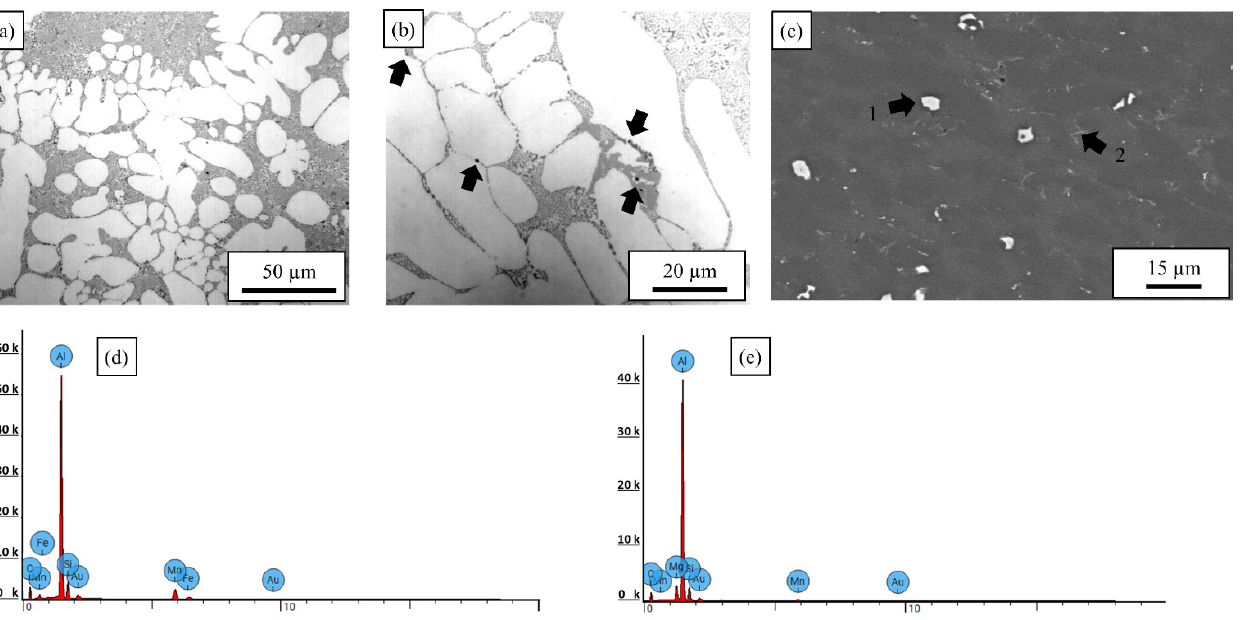
Figure 3. AlSi10MnMg base microstructure in as-cast state: ( a ) general microstructure view; ( b ) detail of Si eutectic and intermetallic particles; ( c ) intermetallic phases in SEM; ( d ) EDX of hexagonal Al-Mn-Fe-Si intermetallic particle 1 of ( c ); and ( e ) EDX of Chinese script Al-Mn-Fe-Si intermetallic particle 2 of ( c ).